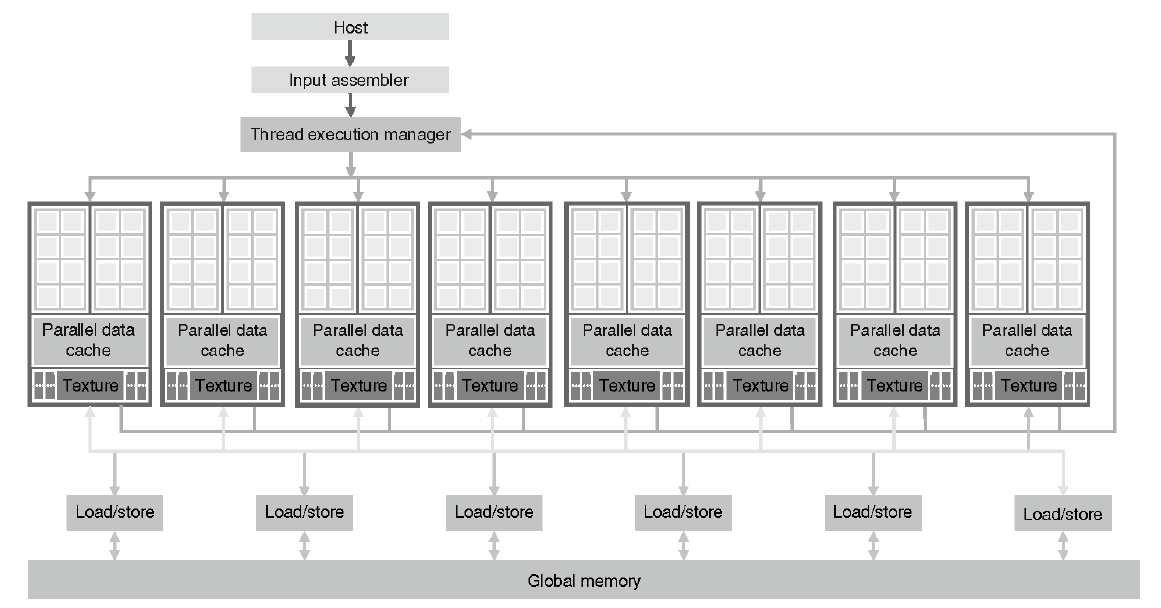
Figure 1. CUDA compatible GPU (graphic processor unit)